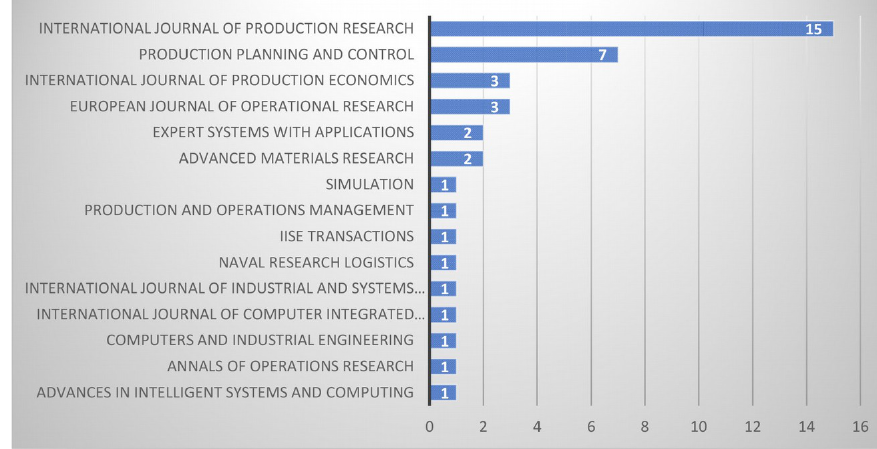
Figure 5. TOC-DBR selected articles in journals by